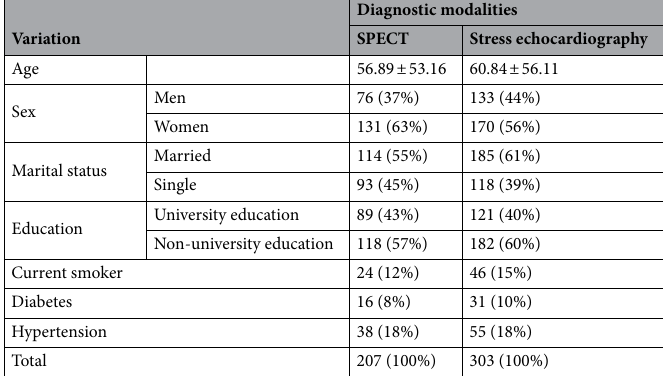
Table1. Demographic characteristics of patients.